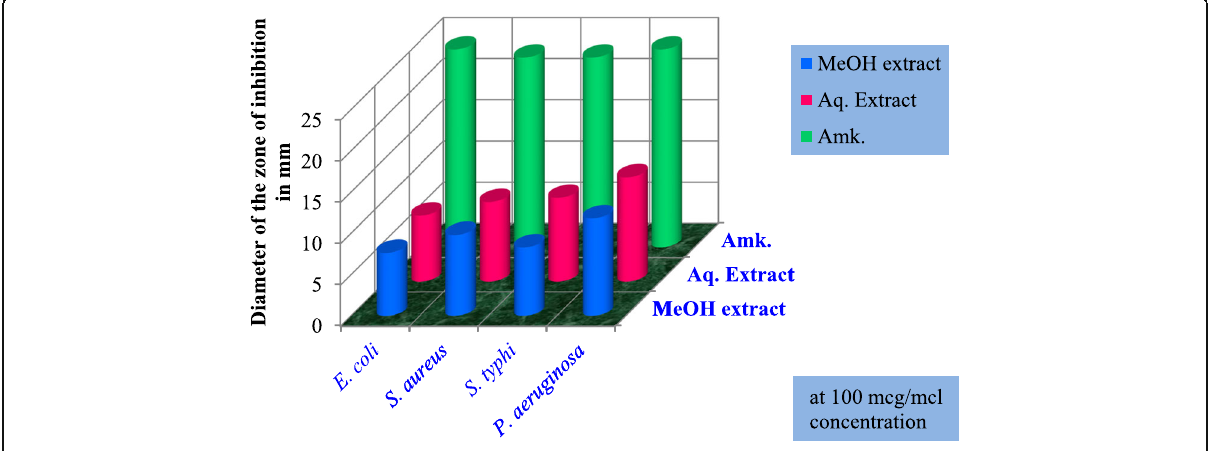
Fig. 3 Bar graph of antibacterial sensitivity of leaf extract at 100 μ g/ μ L concentration